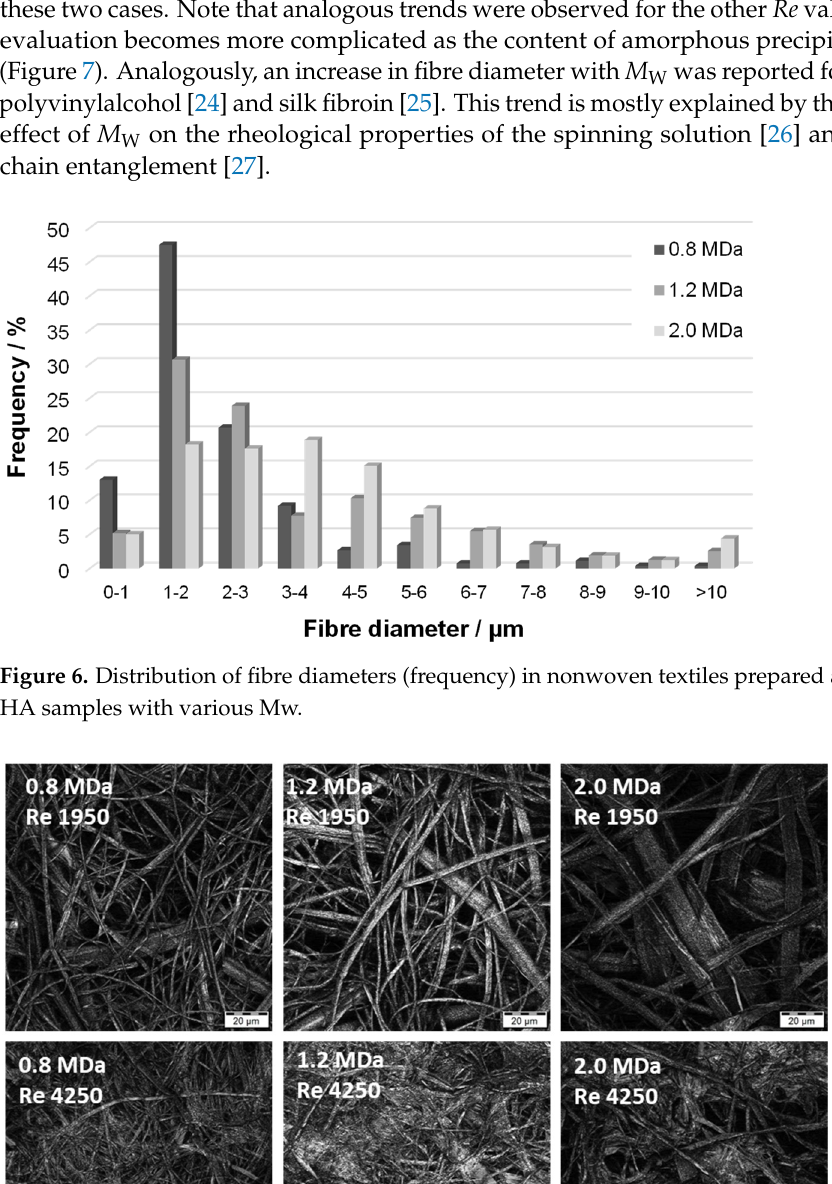
Table 3. Representative filtration times (step of fibre suspension filtration during the textile prepa- ration) measured for various Re and M W of HA.